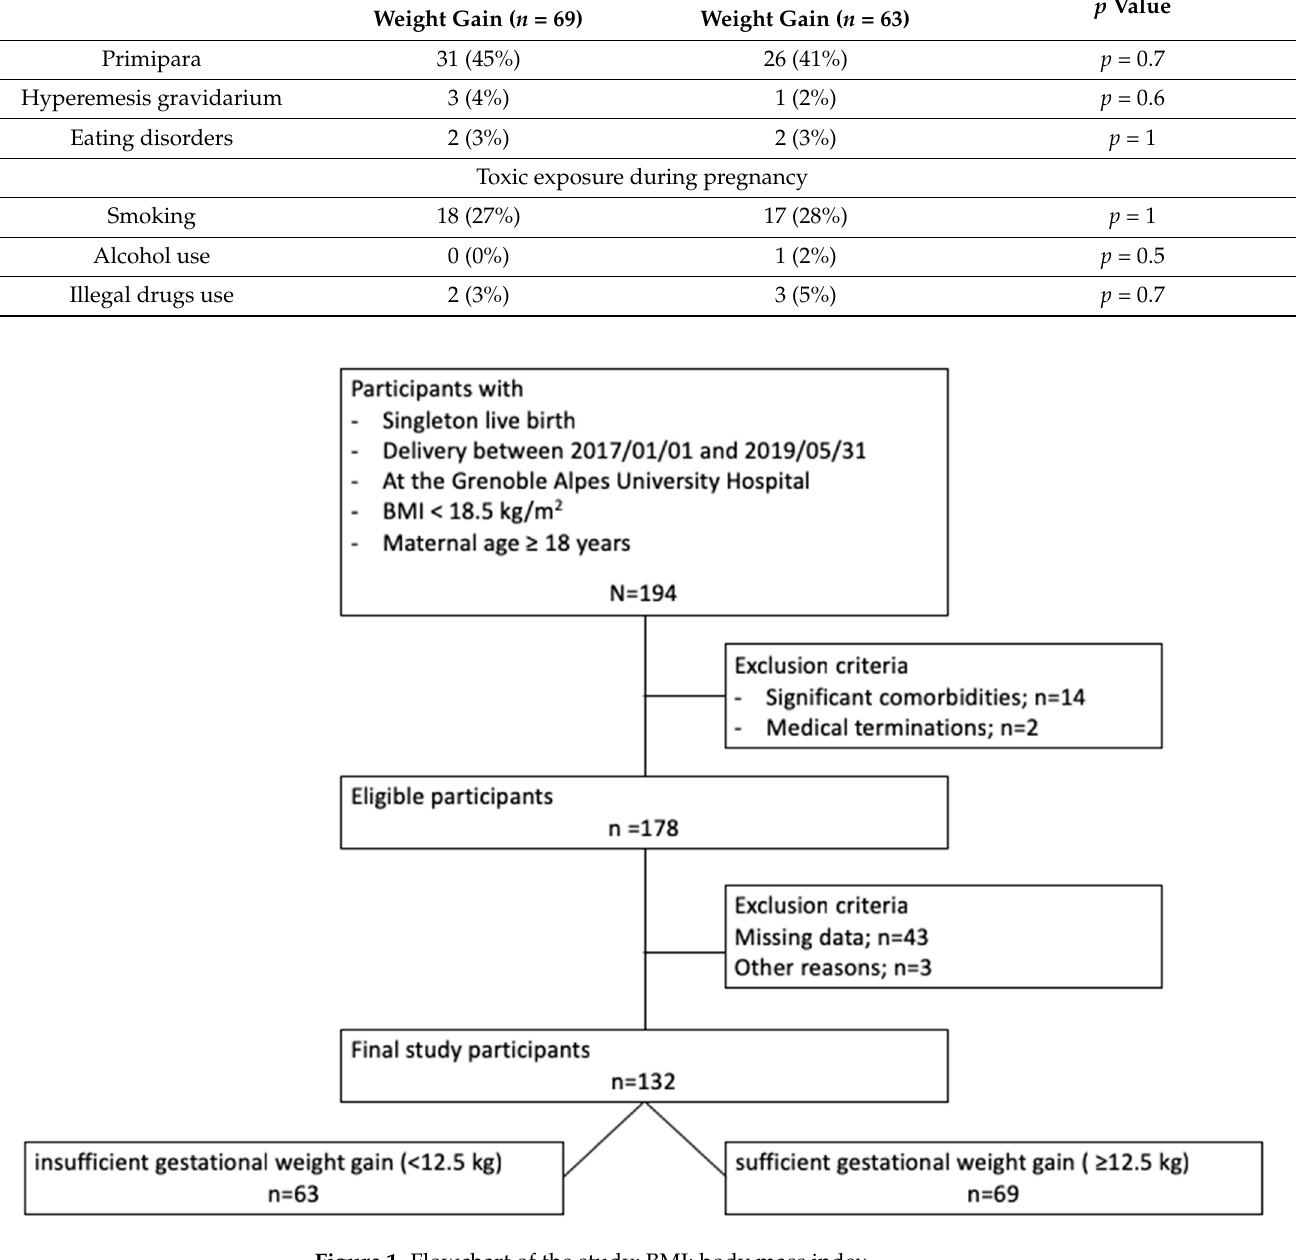
Table 1. Potential pregnancy risk factors of insufficient weight gain in median (IQR) or in number (frequency) according to the status of sufficient ( ≥ 12.5 kg) or insufficient (<12.5 kg·m − 2 ) gestational weight gain. Sufficient Gestational Weight Gain ( n = 69)